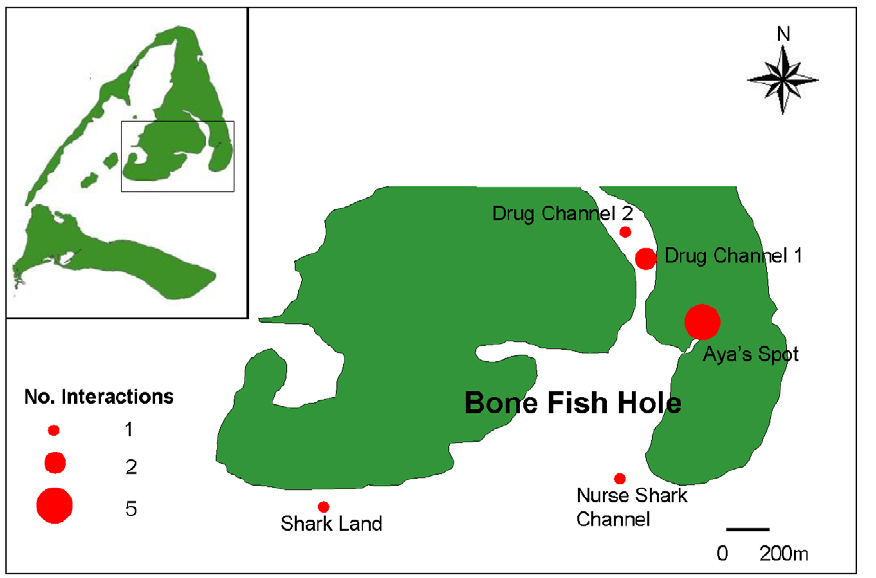
Figure 1. Study and Interaction sites. Map showing study site and locations of lemon shark associations around East Bimini, Bahamas.